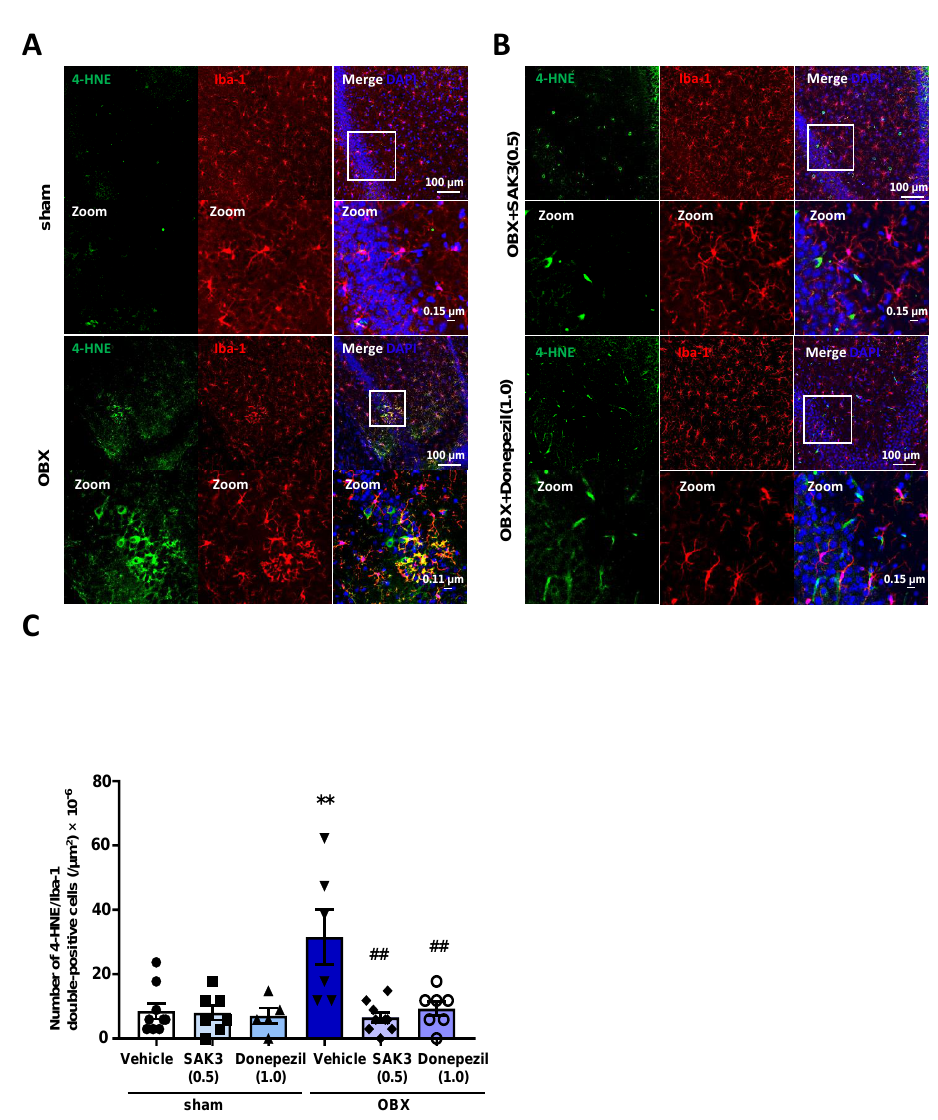
Figure 4. Increased microglial activation levels were restored by acute oral administration of SAK3 and donepezil in the hippocampus, as revealed by immunohistochemistry: ( A , B ) Representative images of triple fluorescence immunostaining with anti-4-HNE, anti-Iba-1 antibody and DAPI in the hippocampus. Scale bars: 100 µ m, 0.15 µ m or 0.11 µ m; ( C ) Quantitative analyses of the number of 4-HNE/Iba-1 positive cells in the hippocampus (n = 5–8 per group). Error bars represent standard error of SEM. The scattered solid circles, squares, regular triangles, inverted triangles, rhombuses and hollow circles inside the histograms were plotted using the real values to show the results clearly. ** p < 0.01 vs. vehicle-treated sham mice; ## p < 0.01 vs. vehicle-treated OBX